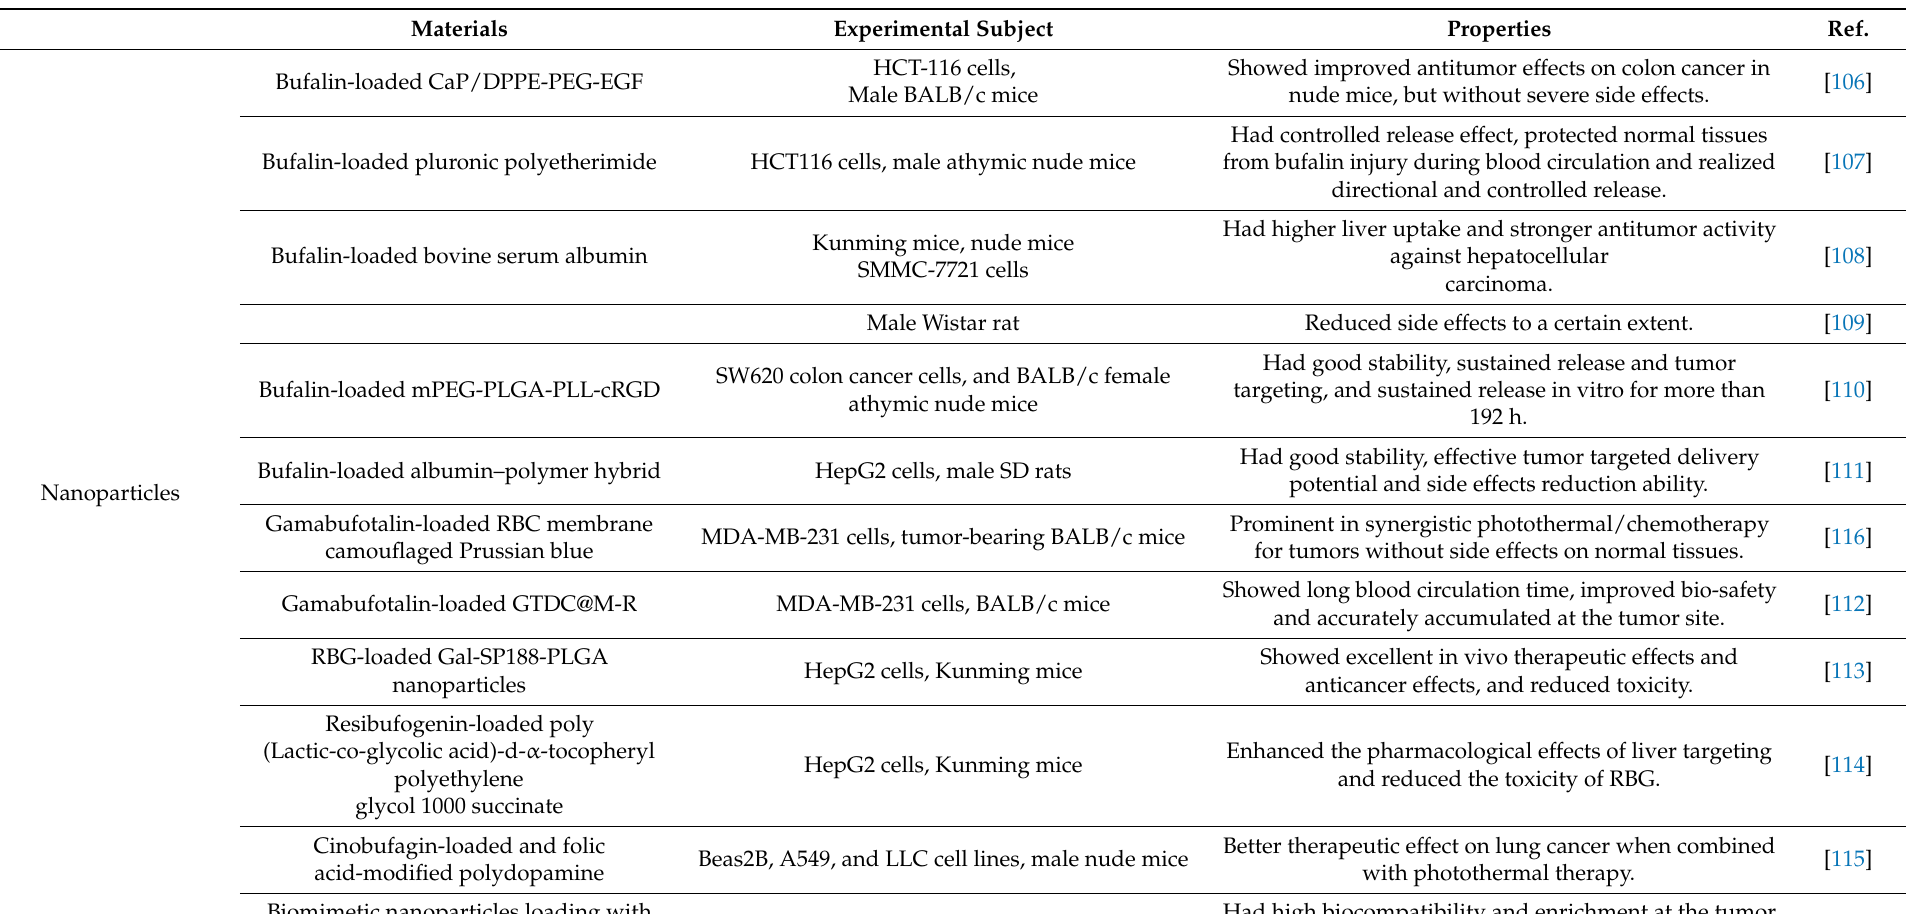
Table 2. Nanodrug delivery